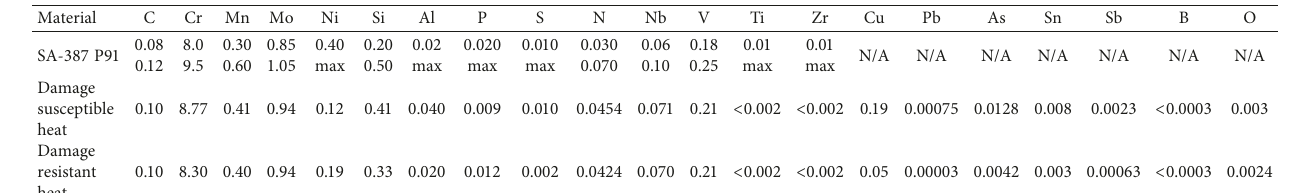
Table 4: Chemical composition (given in weight percent) for two exservice steels compared to the requirements in a typical standard specification